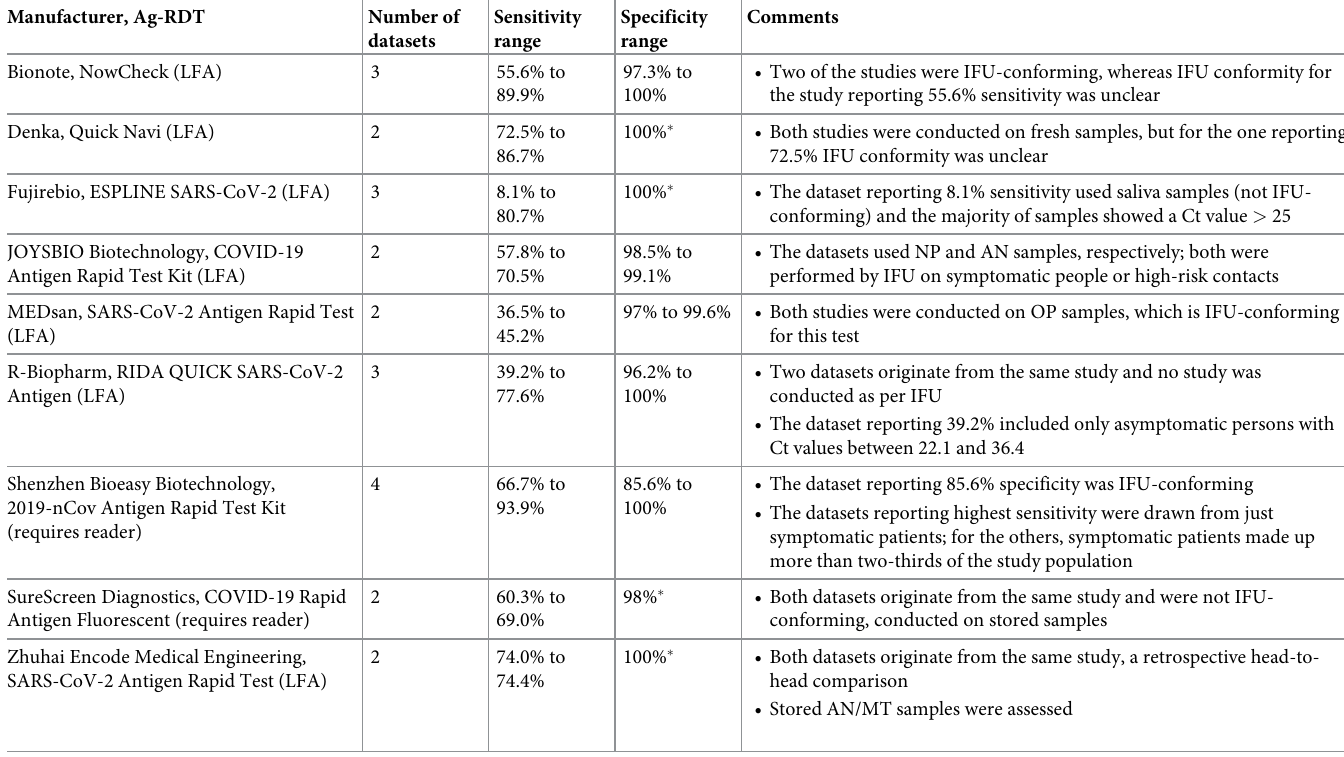
Table 2. Summary clinical accuracy data for major Ag-RDTs not included in the meta-analysis. Manufacturer,